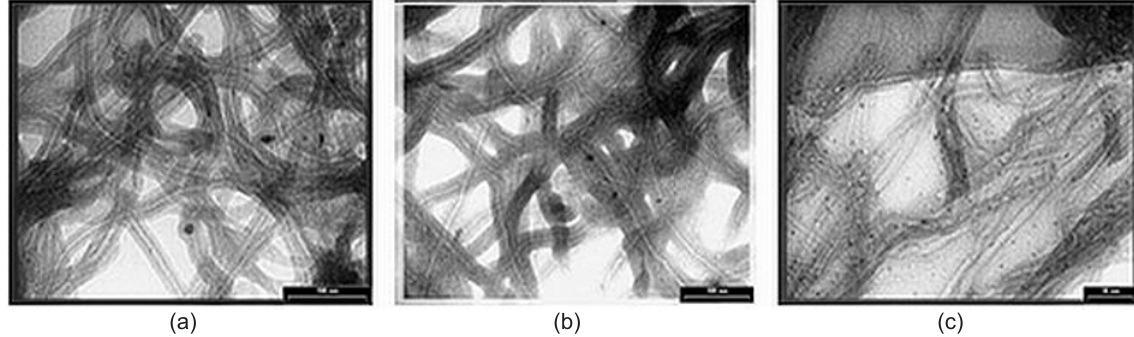
Figure 2. TEM morphologies for: a) MWCNT-COOH-CDDP, b) MWCNT-COOH-DOX, c) MWCNT-COOH-CDDP-DOX.